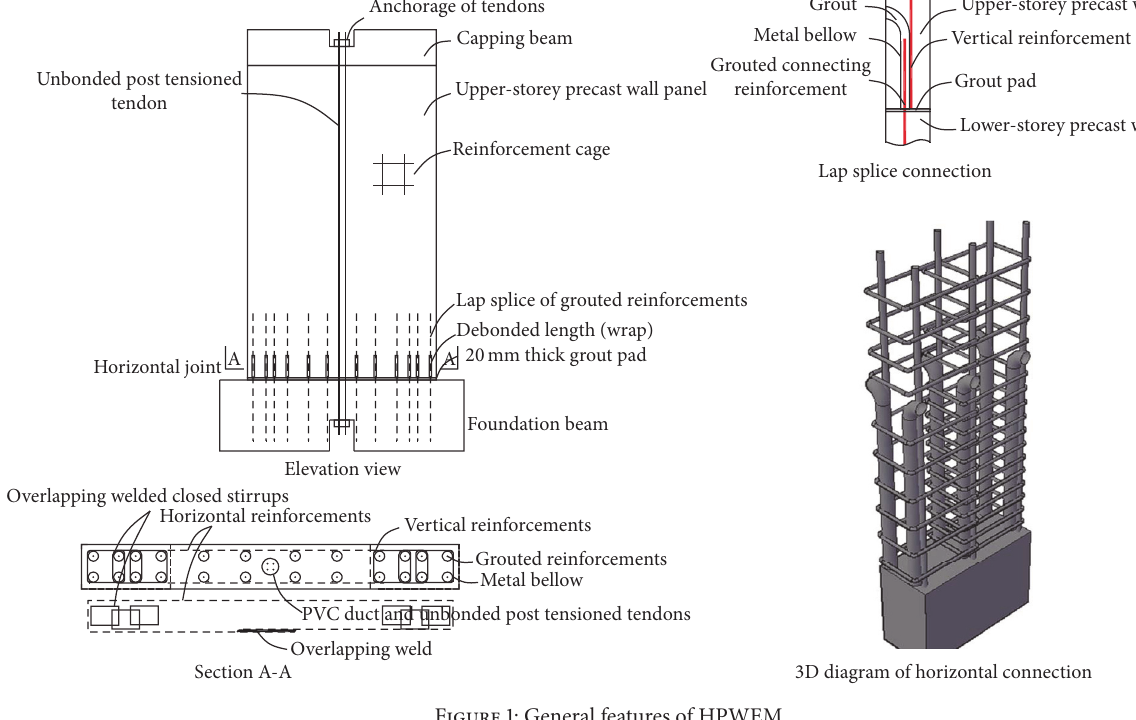
Figure 1: General features of